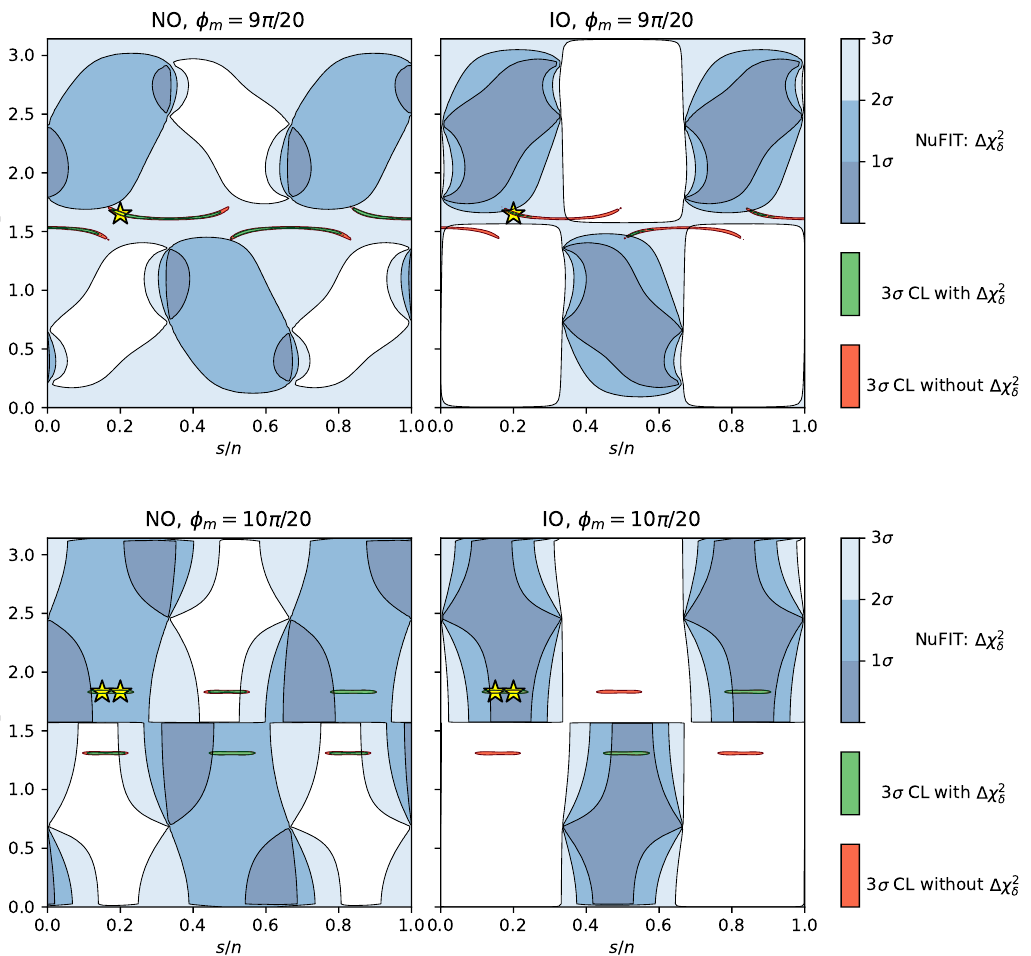
Figure 3 . Case 3 b.1) Impact of the constraints on the value of the CP phase δ for light neutrino masses with NO (left column) and IO (right column) for different values of φ and m = 9 , plots in the upper row) and φ We show the areas, leading to an agreement with the global fit data on the lepton mixing angles and the CP phase δ at the 3 σ level or better, in the s/n − θ coding are the same as in figure 1. The impact of imposing constraints on the CP phase δ is only mild for light neutrino masses with NO, while adding information on the value of δ considerably affects the allowed areas in the s/n − θ to s/n = 4 / 20 is represented by a yellow star in all plots. For φ s = 3 meaning s/n = 3 / 20 with a yellow